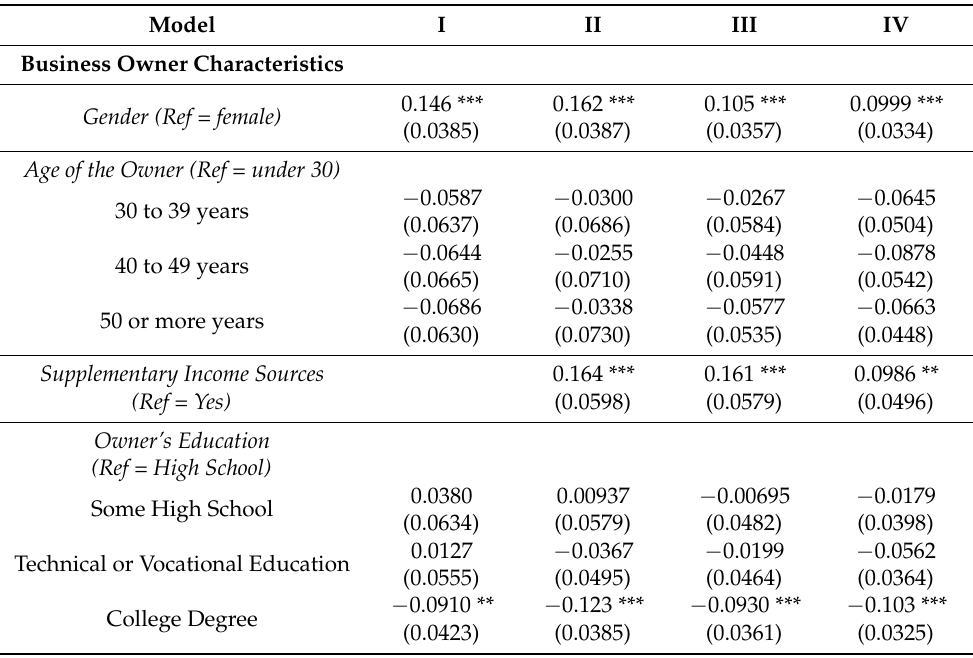
Table 4. Ordered Logit Model for Business Revenue (Low Sales Revenue) Among Latino-Owned Small Businesses: Marginal Effects and Standard Errors +